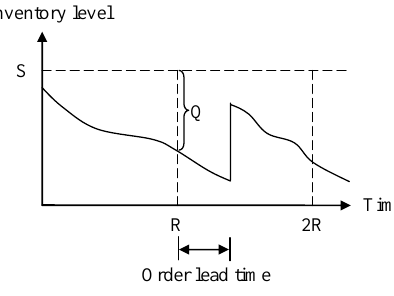
Fig. 4. Example of TBAPR